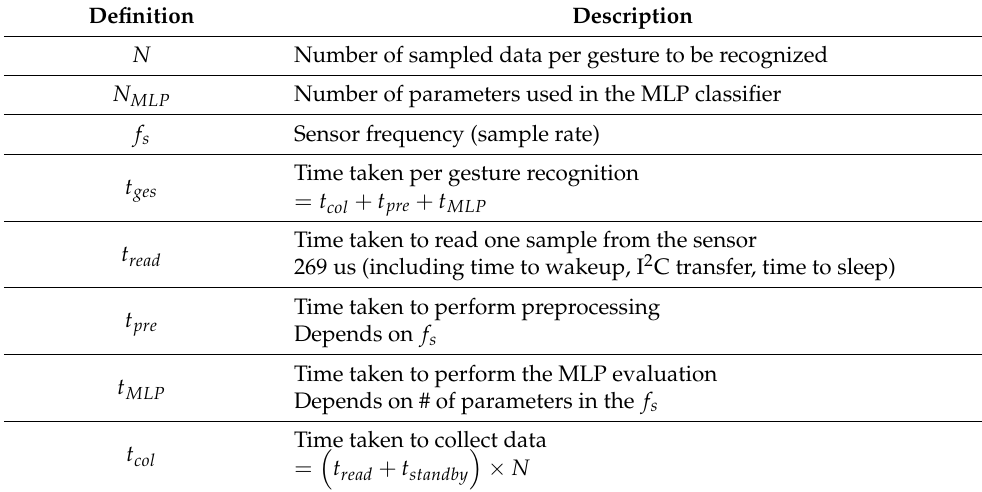
Table 1. Description of the parameters used in the